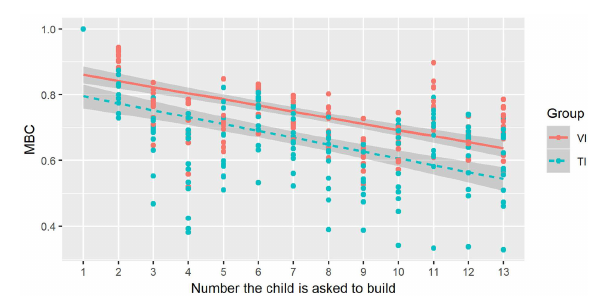
FIGURE 4 | The Minimum Blocks Coefficient (MBC) for each number the child was asked to build. We applied a linear model to data points with a 95% confidence level for each Experimental Group: Virtual Interaction (VI) and Tangible Interaction